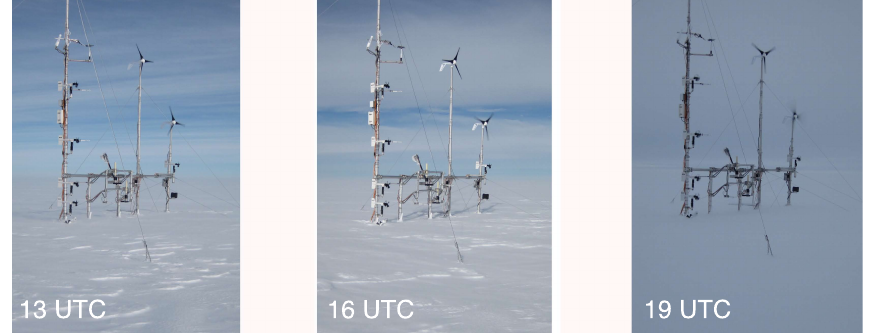
Fig. 9. Automatic camera images of the measurement system on 26 September at 13:00UTC, 16:00UTC and 19:00UTC. The automatic camera was positioned ∼ 10m away of the instrumental set-up.